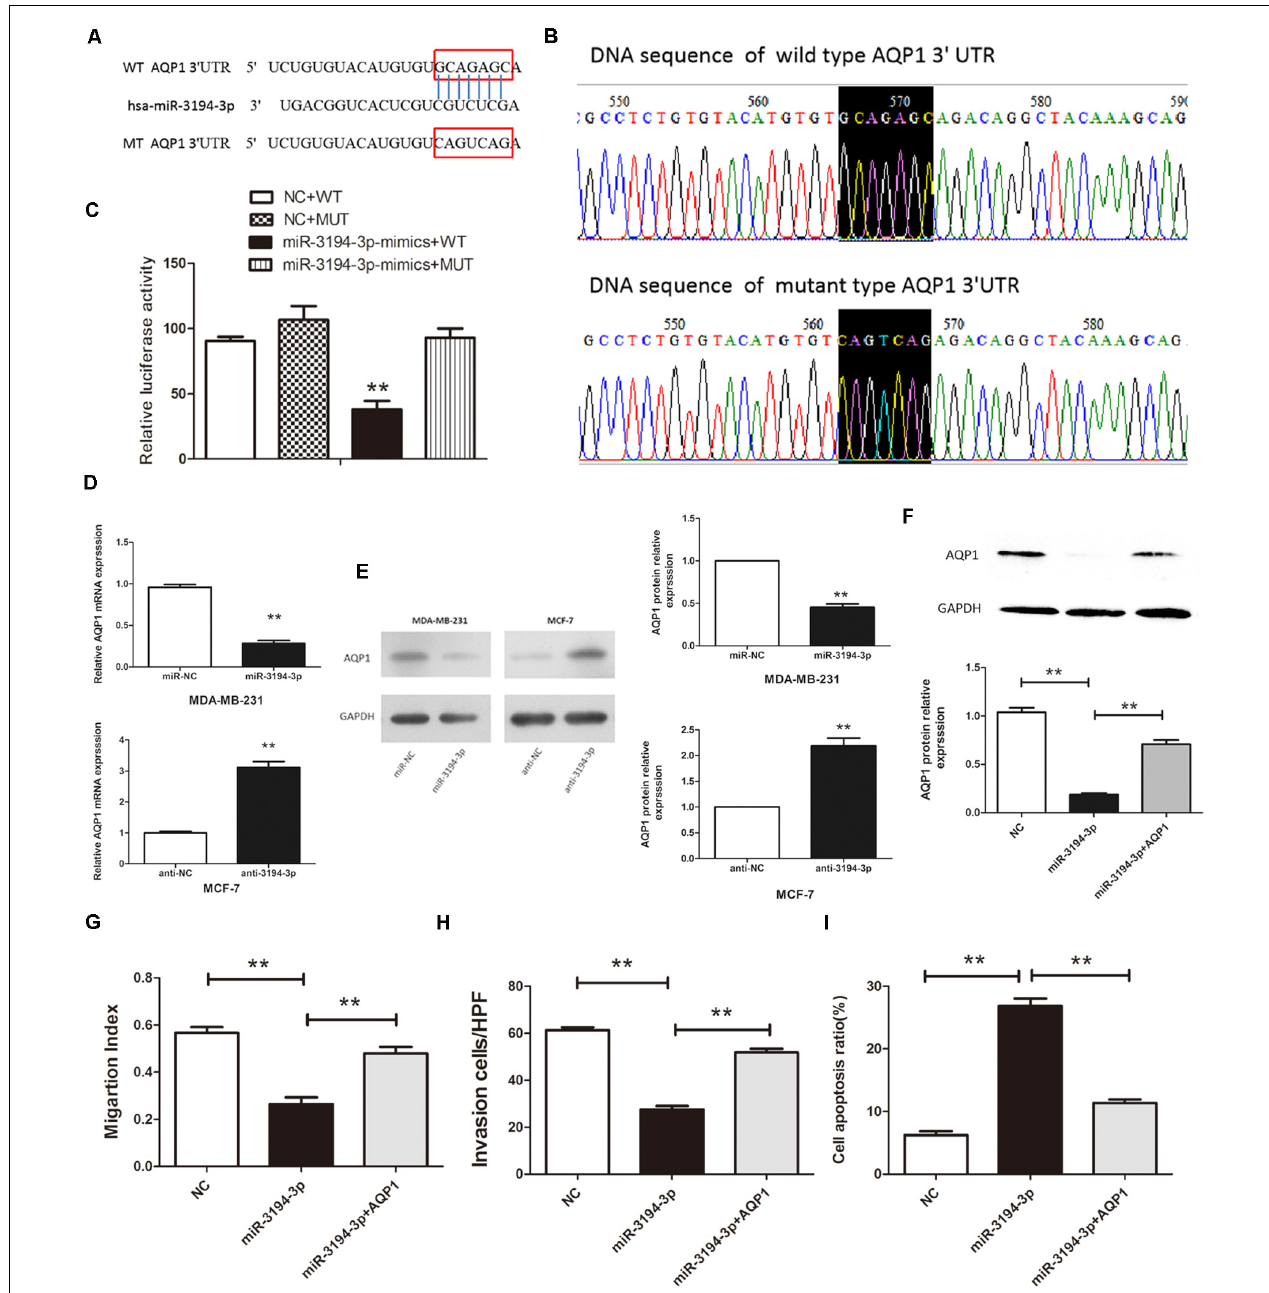
FIGURE 3 | miR-3194-3p negatively regulates the expresssion of AQP1 by binding to the 3 (cid:48) -UTR of its mRNA. (A) The predicted miR-3194-3p-binding site in the AQP1 3 (cid:48) -UTR. (B) Mutations were generated and sequenced at the putative miR-3194-3p-binding site located in the AQP1 3 (cid:48) -UTR. (C) Either the WT or MUT reporter plasmid was cotransfected with either miR-3194-3p or NC oligo into HEK293T cells, and the luciferase activity was determined. (D) qRT-PCR analysis and (E) Western blot analysis of AQP1 expression in MDA-MB-231 and MCF-7 cells transfected with miR-3194-3p mimic/inhibitor and their negative controls. (F) Western blot analysis of AQP1 expression in MDA-MB-231 cells cotransfected with pBABE-puro- AQP1 and miR-3194-3p mimic. (G) Cell migration, (H) cell invasion, and (I) cell apoptosis was measured in MDA-MB-231 cells cotransfected with pBABE-puro- AQP1 and miR-3194-3p mimic (** P < 0.01).